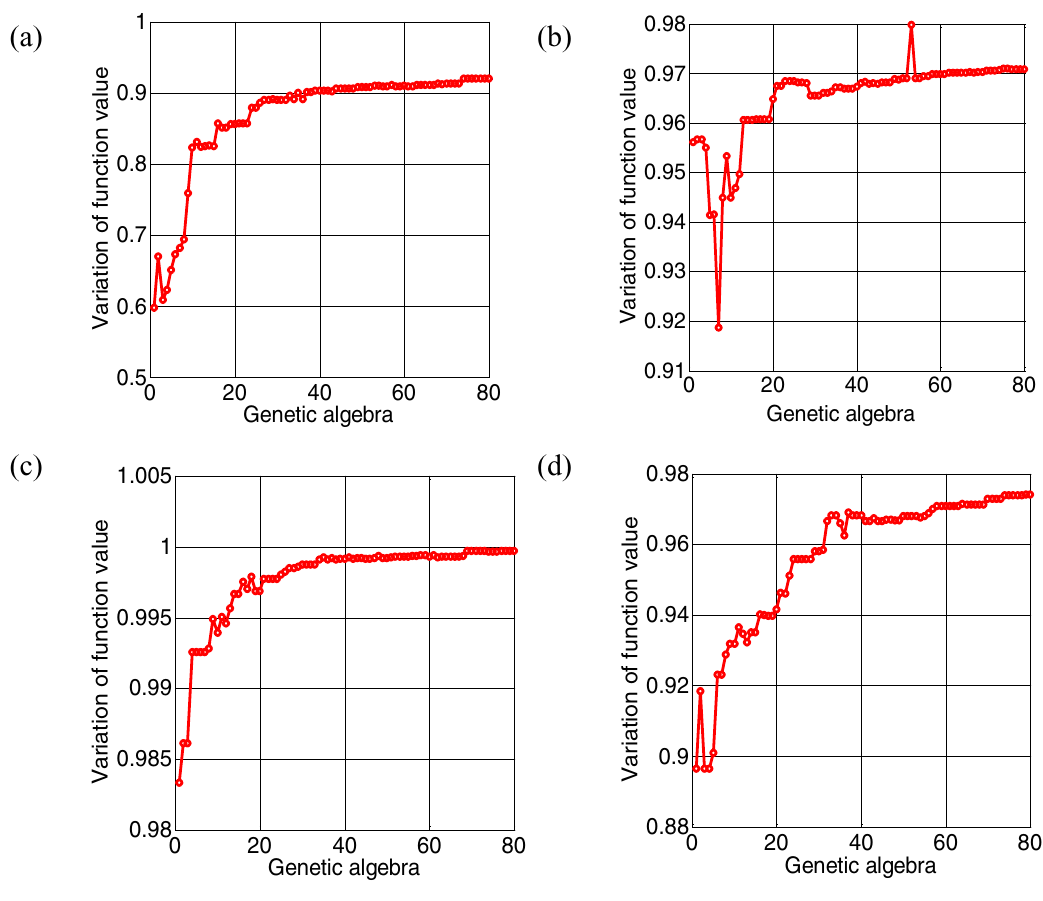
Figure 7: Sound absorption coefficient evolution process of PM at different frequency bands and fixed frequency points: (a) in low frequency band, (b) in middle frequency band, (c) in high frequency band, (d) at fixed point